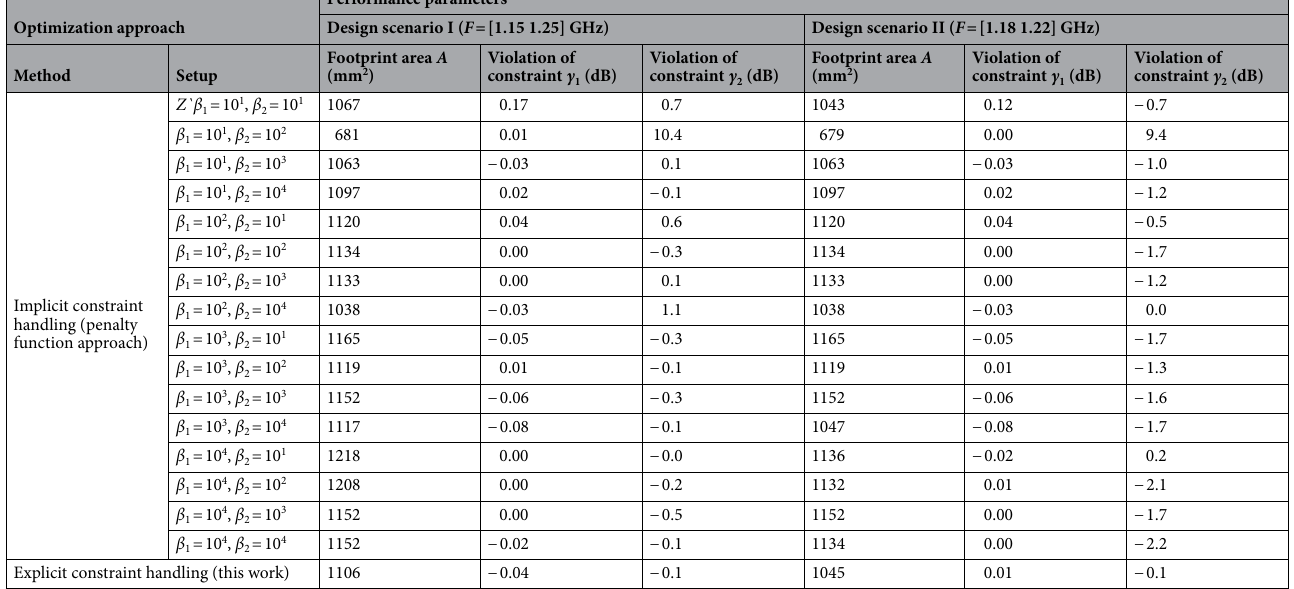
Table 4. Optimization results for Circuit